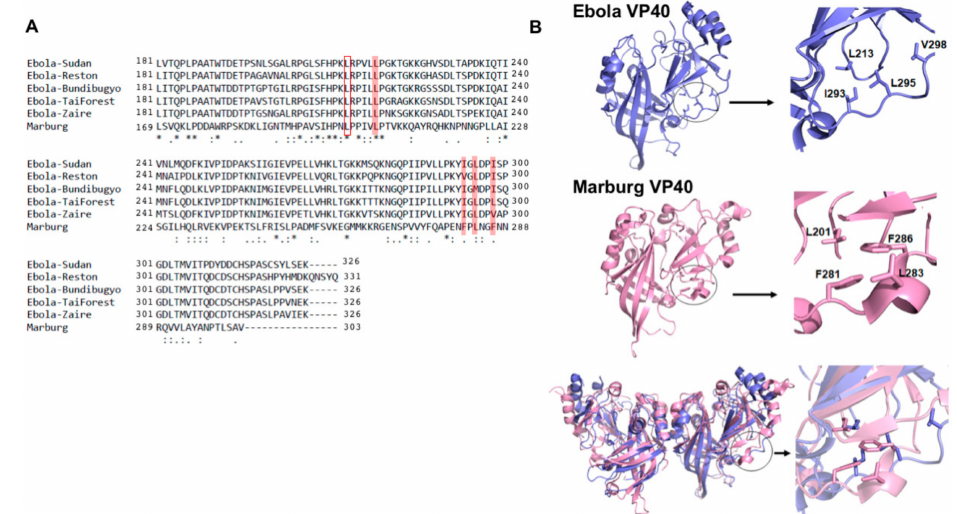
Figure 1. Marburg virus (MARV) VP40 (mVP40) and Ebola virus (EBOV) VP40 (eVP40) proteins have a similar hydrophobic loop region in the C-terminal domain (CTD). ( A ) Sequence alignment of eVP40 and mVP40 shows that Leu 201 of mVP40 is conserved and aligns with Leu 213 of eVP40 (open red box). The hydrophobic loop region of eVP40 Zaire composed of Ile 293 , Leu 295 and Val 298 residues aligns with Phe 281 , Leu 283 and Phe 286 residues of mVP40 indicating conservation of hydrophobic character of this region (solid red box). The sequence alignment was created using clustalW. “*” shows conserved residues in all 5 strains of eVP40 and mVP40. “ : ” Represents residues that are mostly conserved “.” represents residues that are somewhat conserved between the strains. ( B ) Orientation of hydrophobic loop region on eVP40 and mVP40. eVP40 monomer (blue) and mVP40 monomer (pink) with the hydrophobic loop enlarged. The bottom panel is a structural alignment of the eVP40 and mVP40 proteins is also shown.